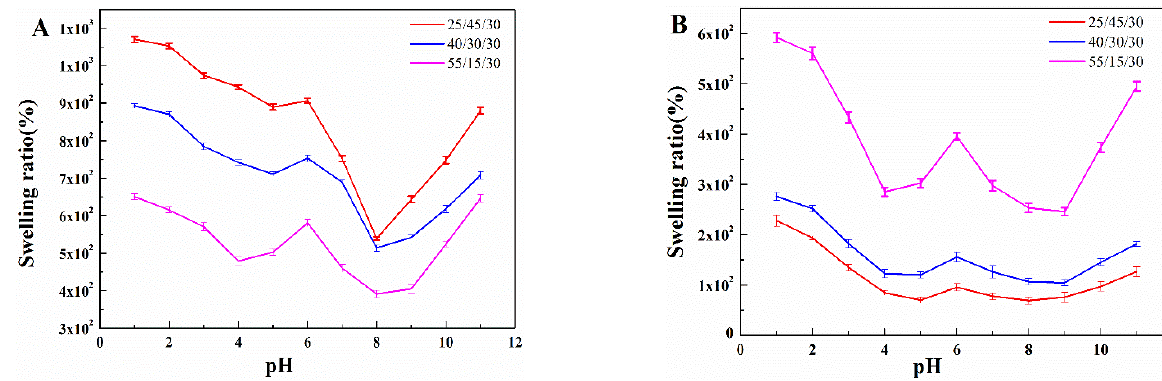
Figure 6. Swelling ratio of sericin/PNIPAM/PEO hydrogels in pH buffer solutions at ( A ) 15 °C and ( B ) 37 °C, the final results of data are shown as mean ± standard deviation.